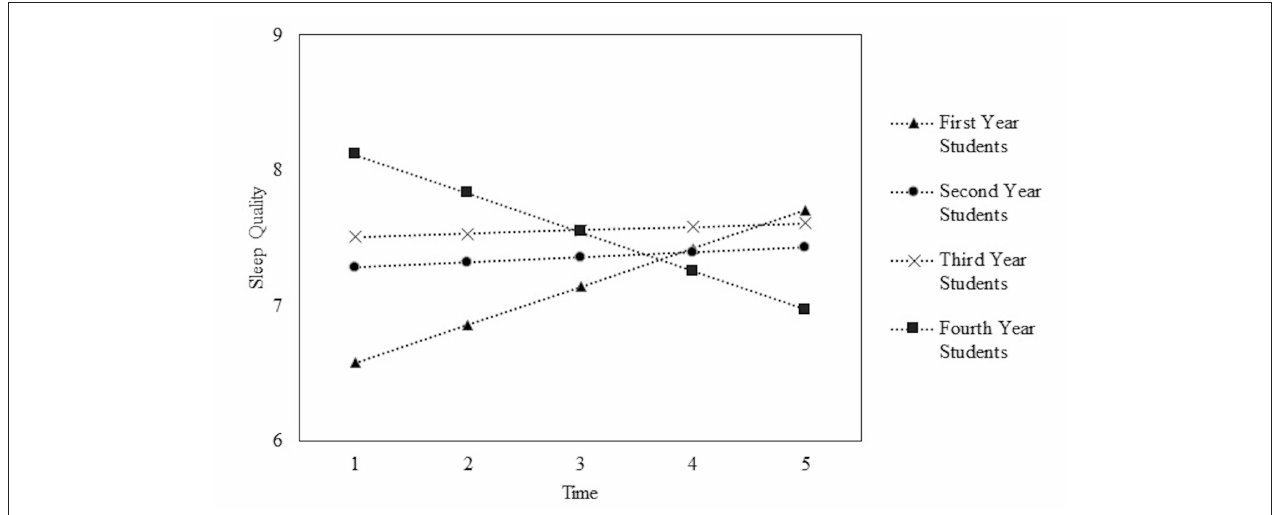
FIGURE 1 | Plot of average time courses for first, second, third, and fourth year veterinary students sleep quality scores across the academic year. Time 1 = beginning of the academic year and Time 5 = end of the academic year.